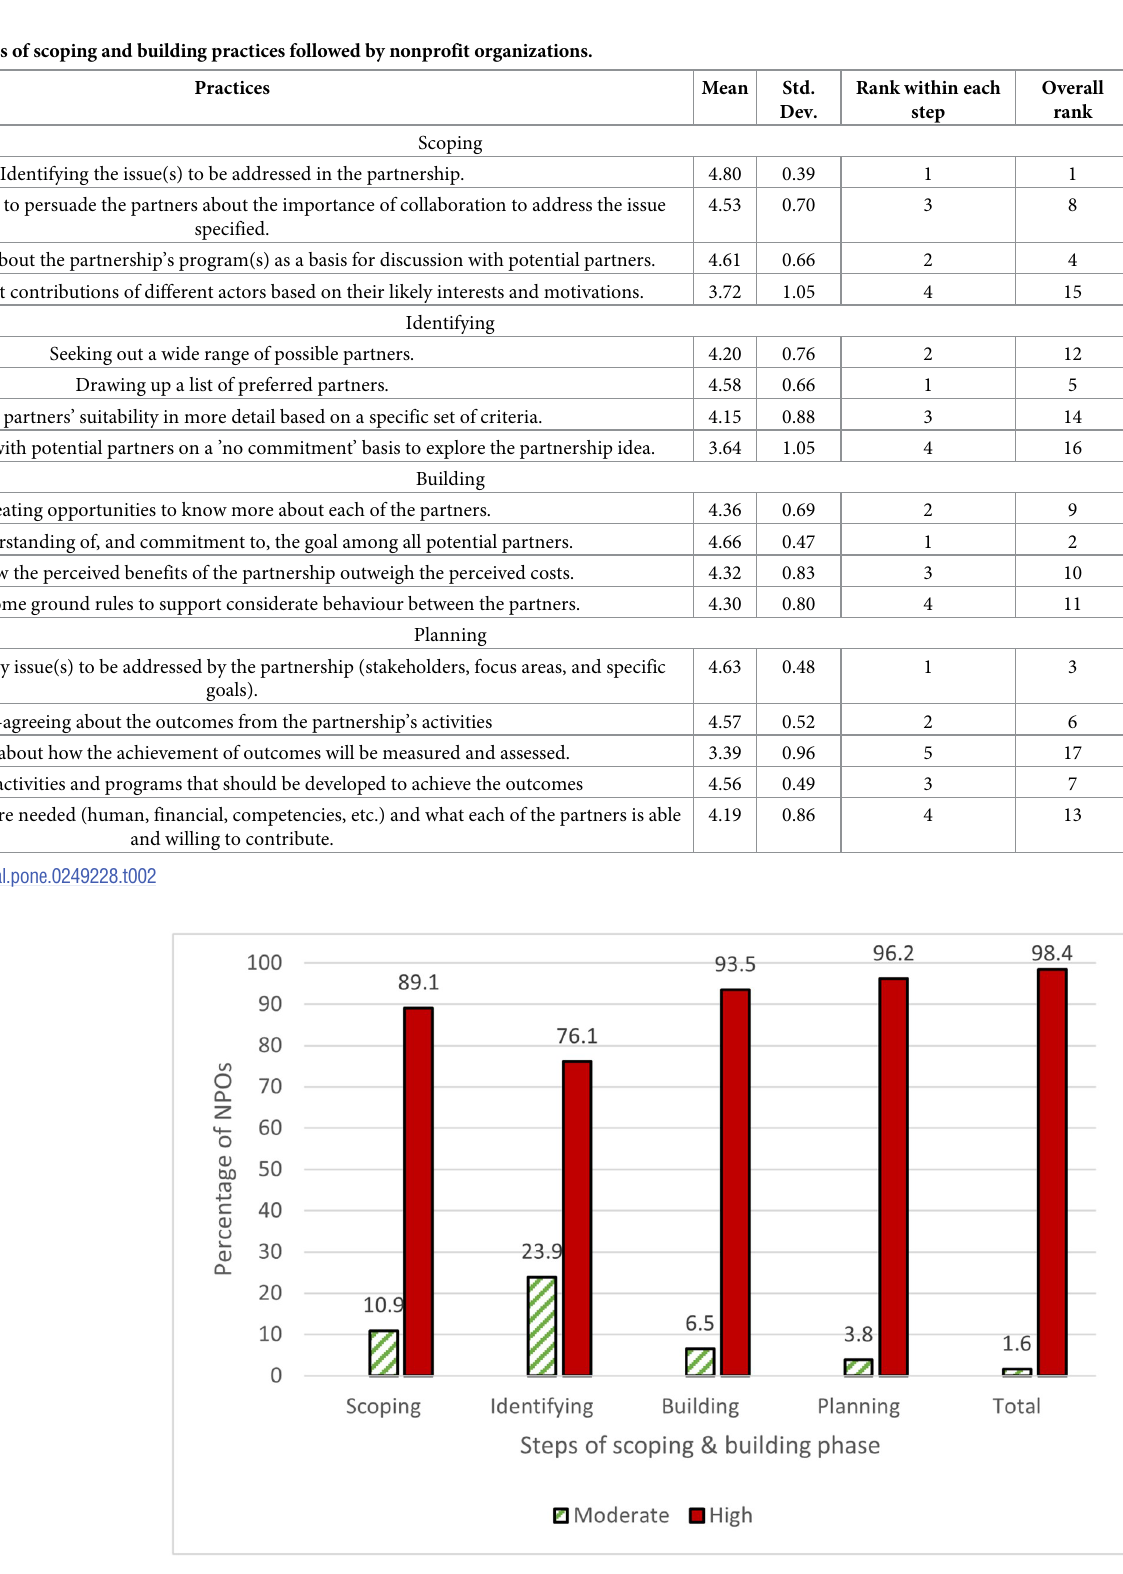
Fig 2. Nonprofit organizations’ implementation level in the scoping and building